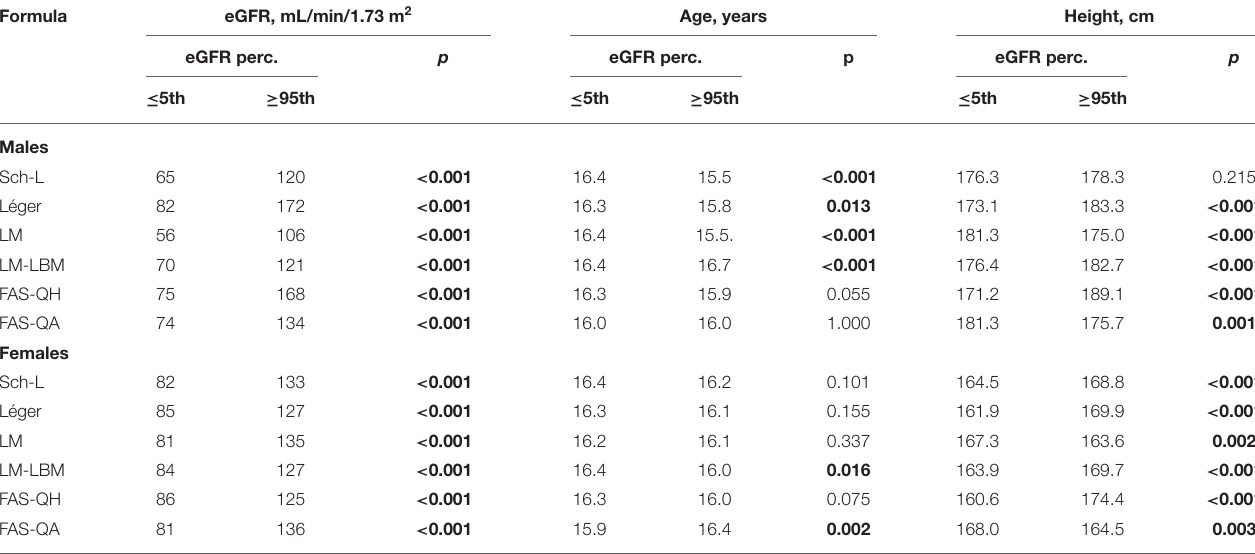
TABLE 5 | Mean estimated glomerular filtration rate, mean age, and mean height of males and females assigned by six formulae to the lower ( ≤ 5th) and the upper ( ≥ 95th) tail of each distribution. Formula eGFR, mL/min/1.73 m 2 Age, years Height, cm eGFR perc. eGFR perc. eGFR